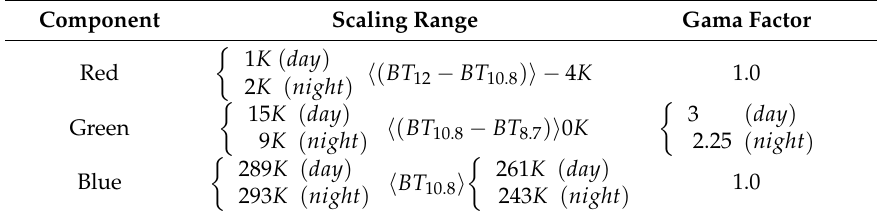
Table 2. Dust RGB channel enhancement. The “night-mode” flag is raised when solar zenith angle exceeds 85 ◦